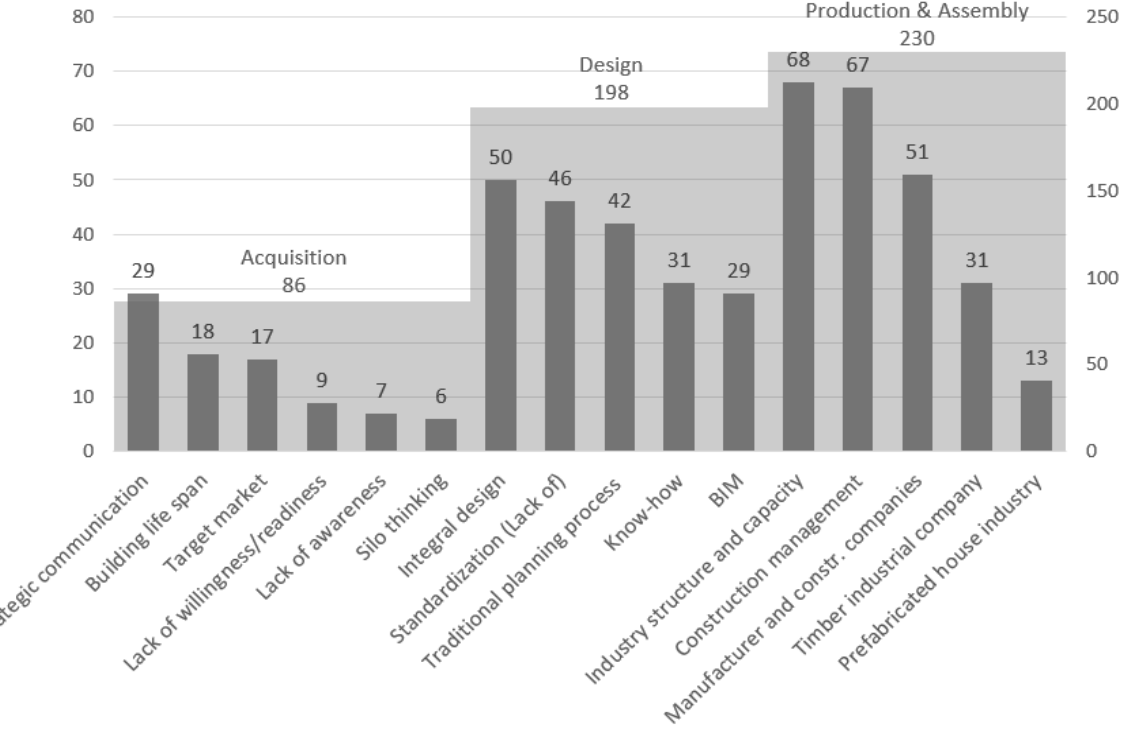
Figure 3. Frequency of nominations of all three categories (right y-axis) with their codes (left y-axis).